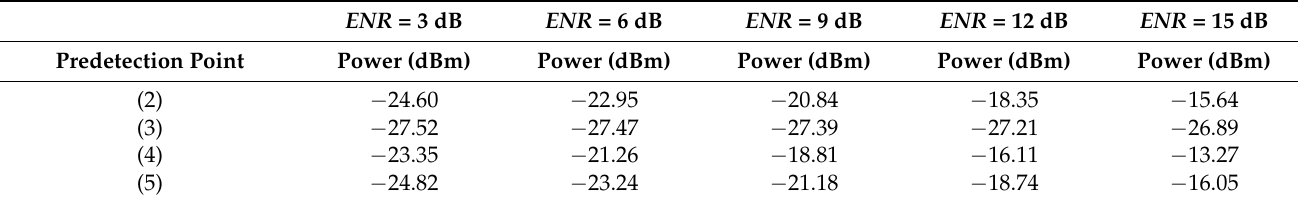
Table 6. The simulated output power at each predetection point in the schematic of Figure 2 for varying power level noise-like input signals at the antenna port using a noise source ( T ref = 290